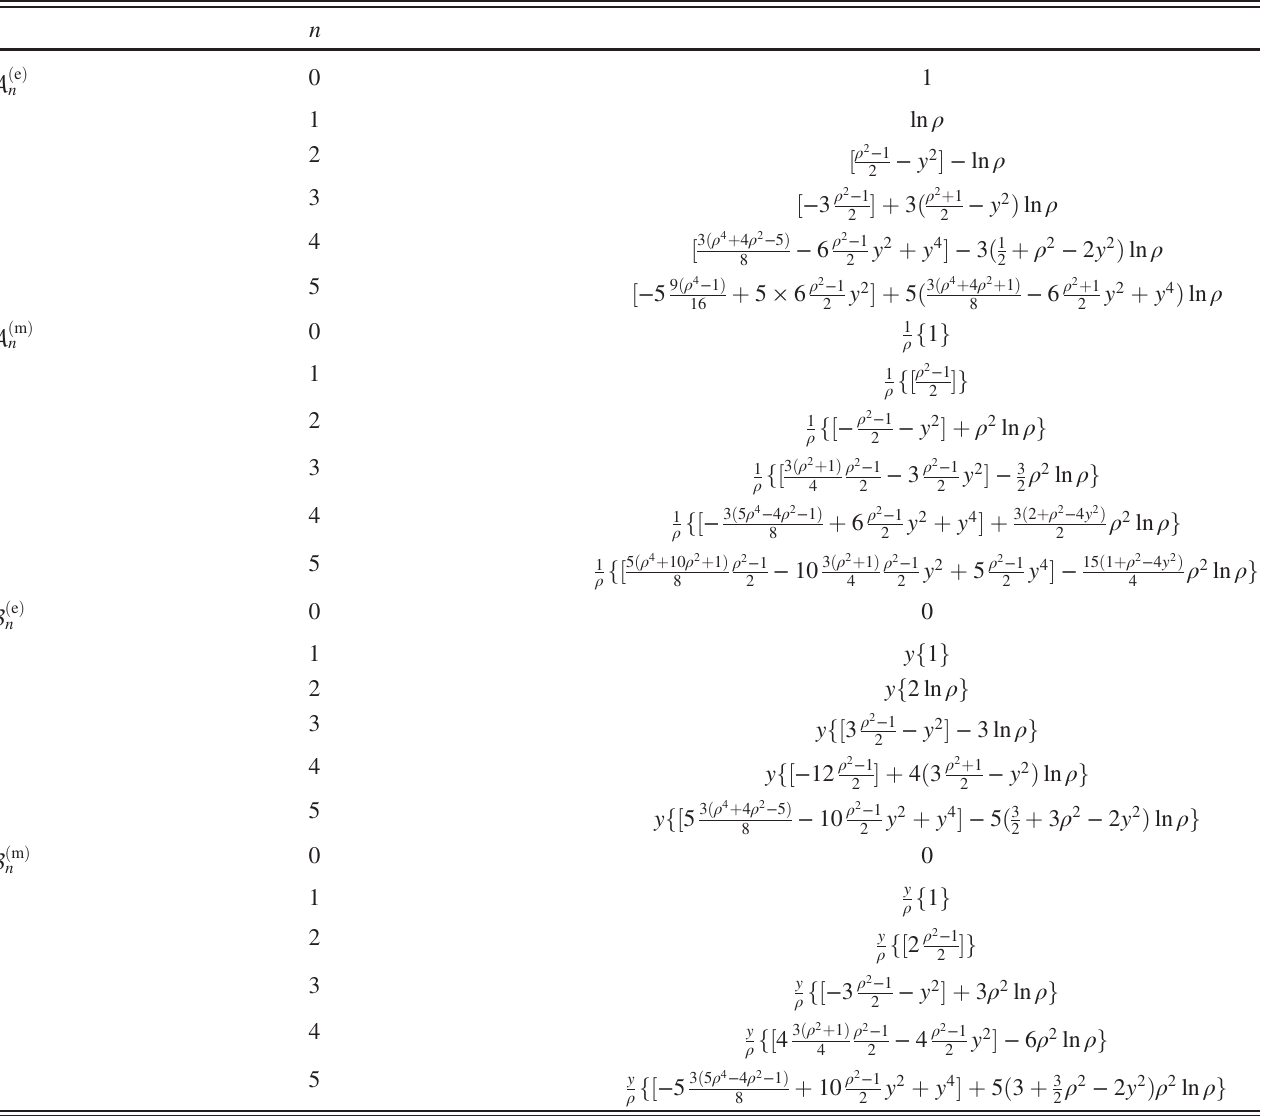
TABLE VIII. Sector